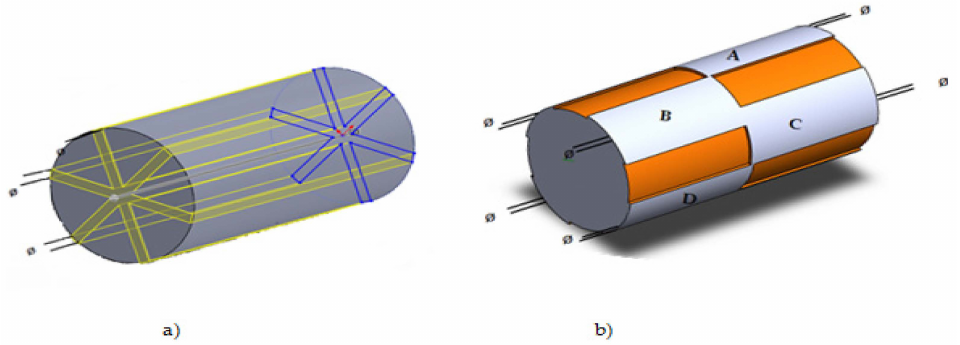
Figure 12. Inner rotating field eddy current transducer: ( a ) three phase rectangular coils; ( b ) A, B,C . . . .,H: flat rectangular pickup